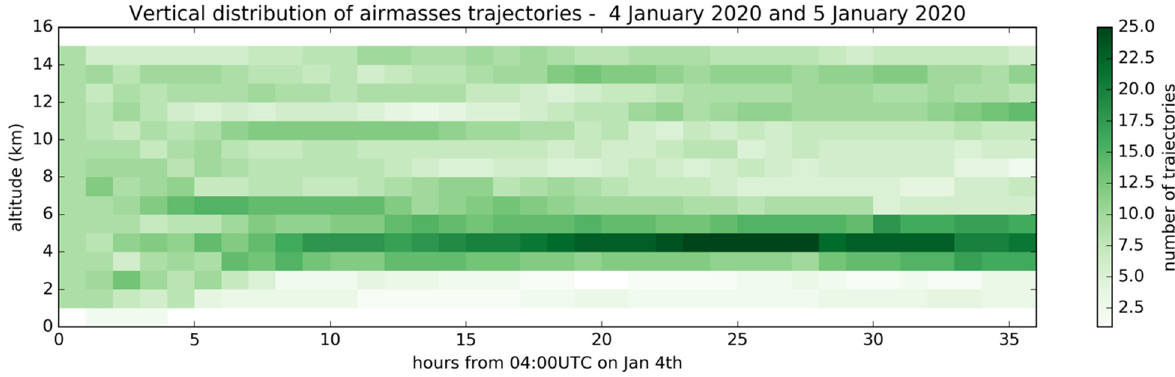
Figure 5. Density of trajectories as a function of altitude during the transport.